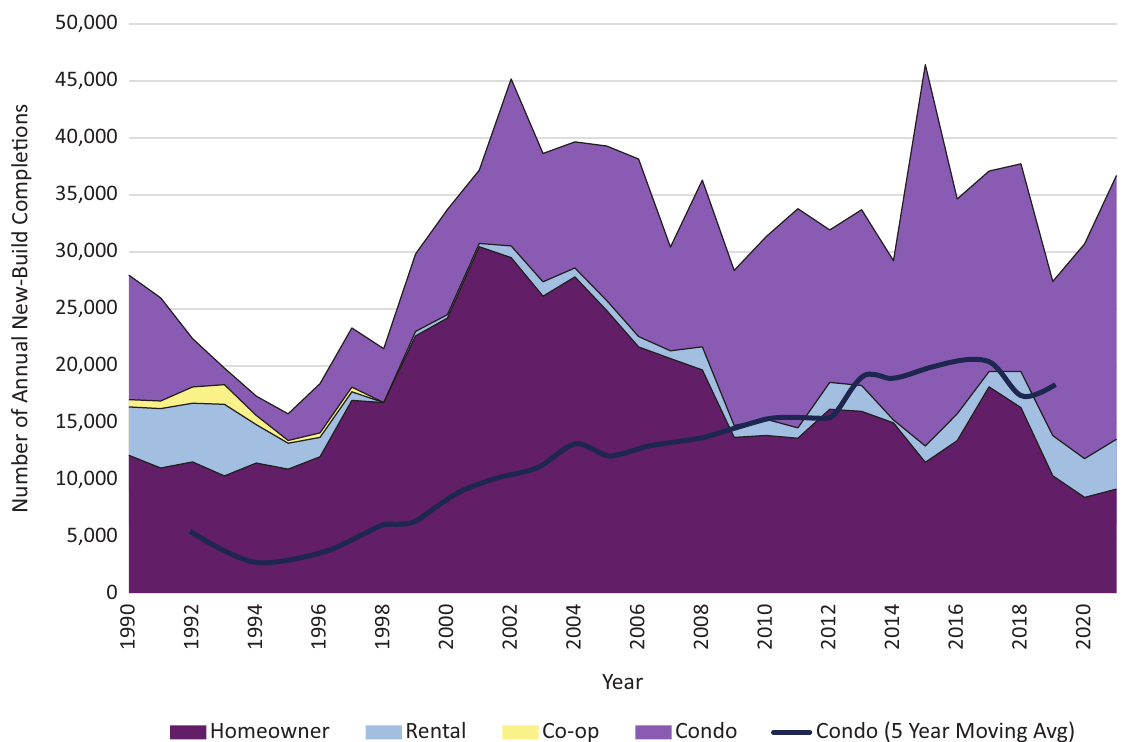
Figure 2. New build housing completions by intended market in the Toronto CMA, 1990–2021. Source: Calculated by the authors using data from CMHC